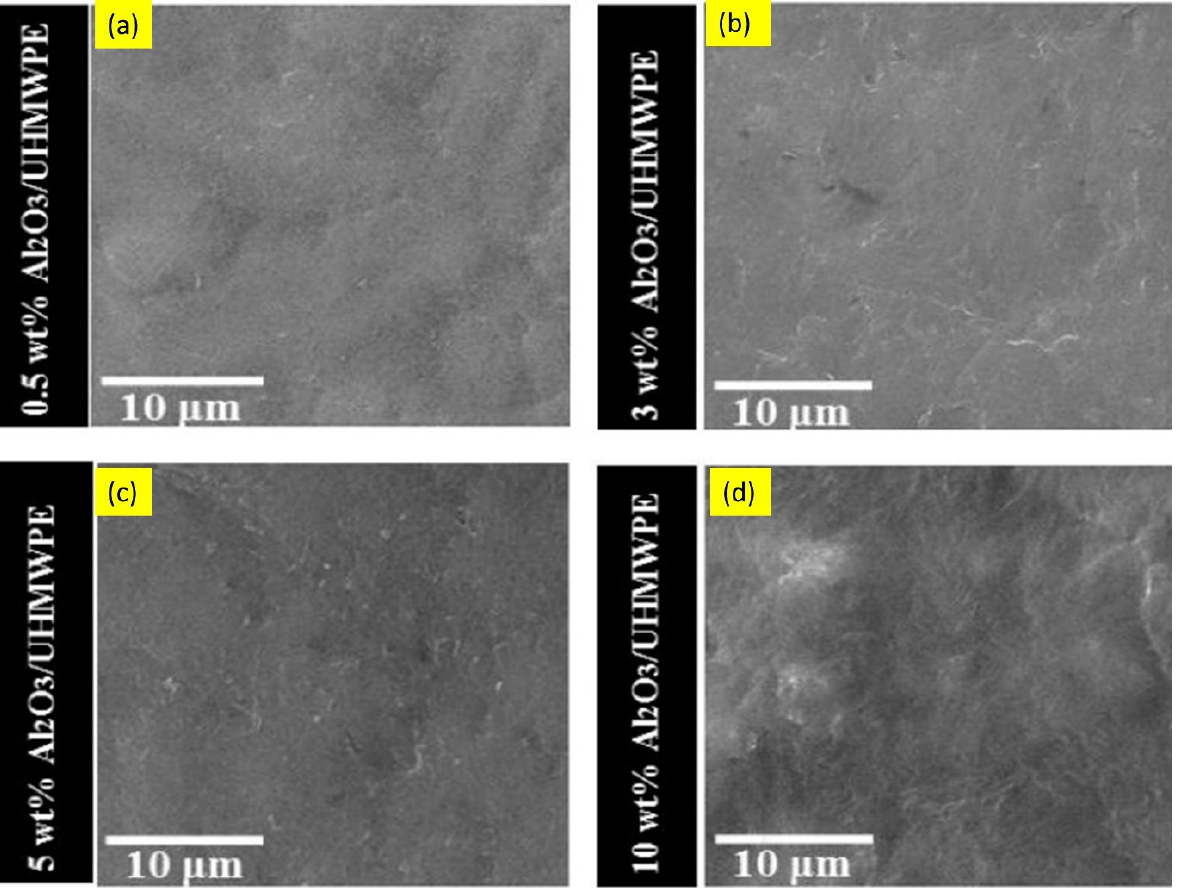
Figure 12. FESEM images for UHMWPE polymer coatings reinforced with ( a ) 0.5, ( b ) 3, ( c ) 5 and ( d ) 10 wt % nano-alumina particles [196].